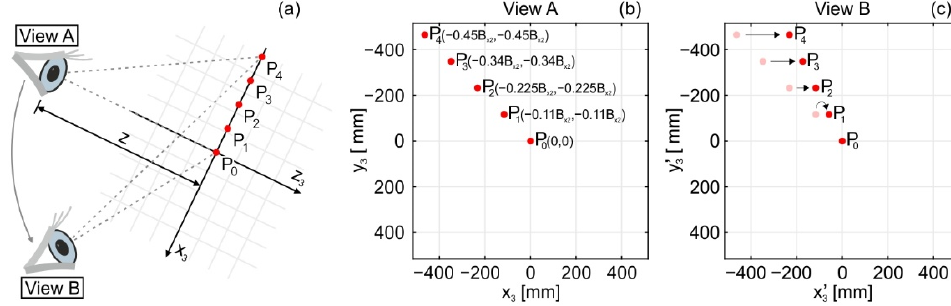
Figure 4. ( a ) Investigated geometry for viewpoint change; ( b ) starting points positions in the image space; ( c ) perspectives on point object for ‘View A’ and ‘View B’.